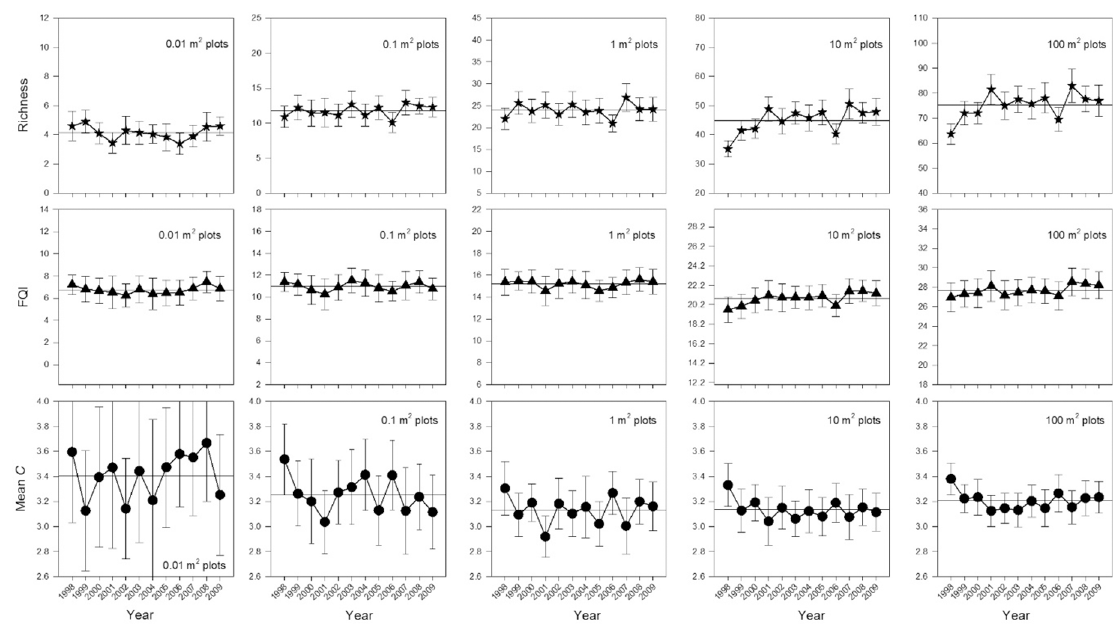
Fig 4. FQA values across sample years for five different plot sizes ( ± 95% CI; N = 20). Horizontal lines provide reference levels for comparison. Horizontal reference line indicates average of points for that plot ’ s size (1998 –